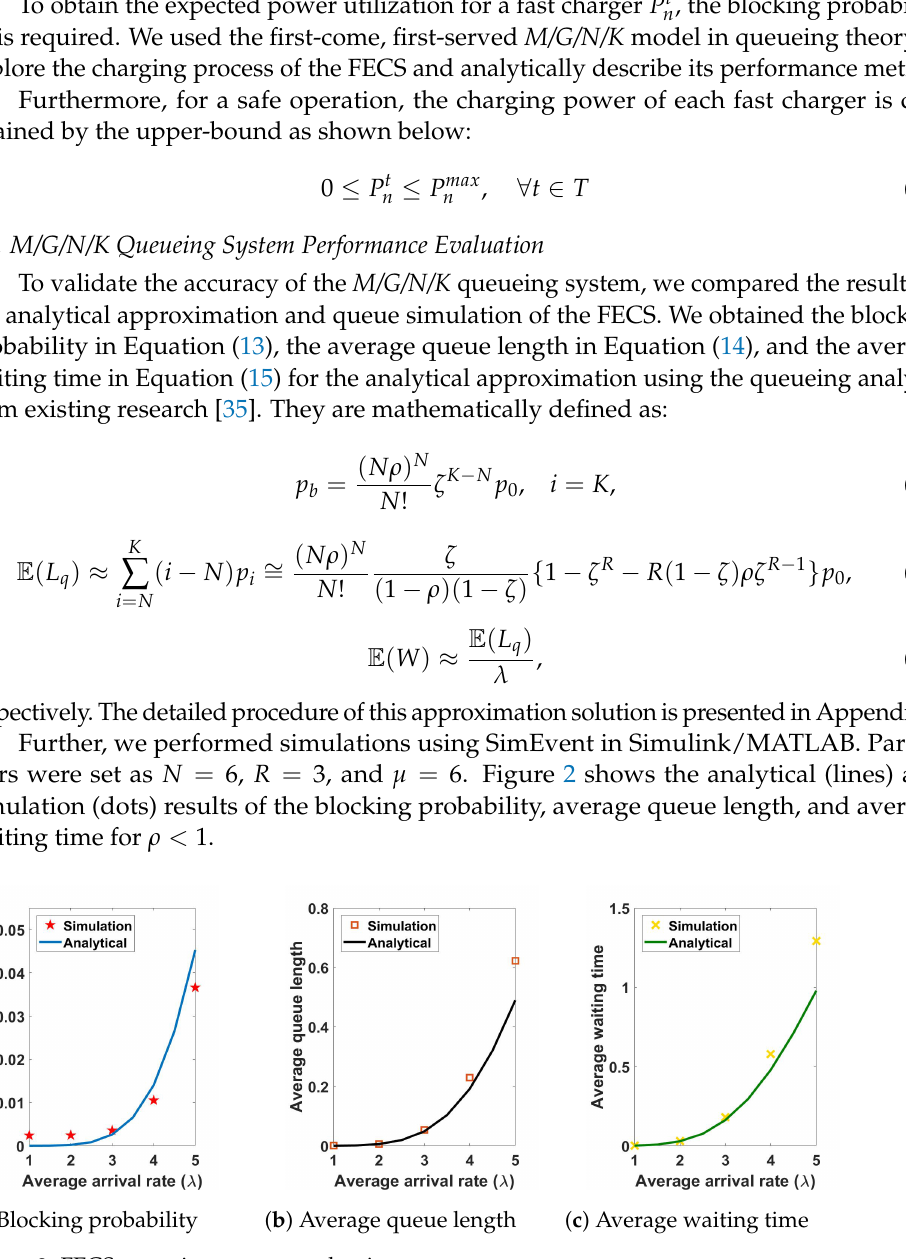
Figure 2. FECS queueing system